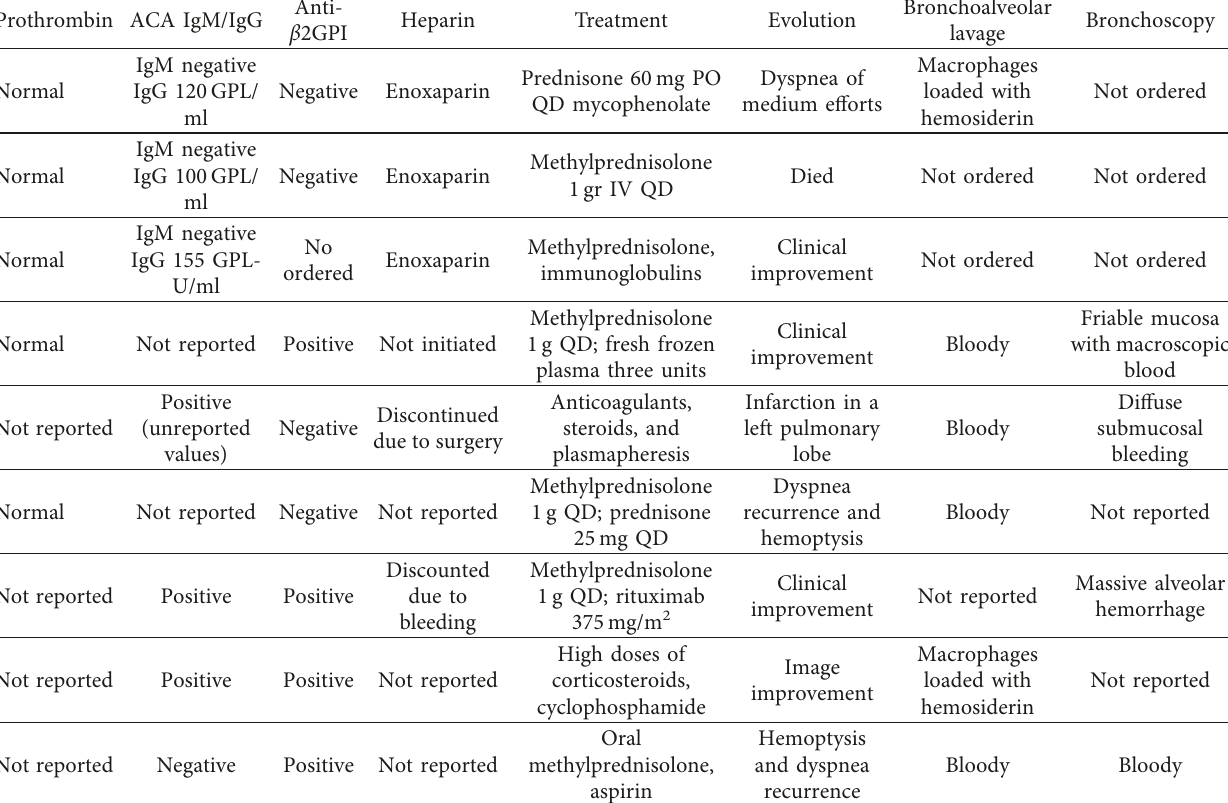
Table 4: Comparison of characteristics of patients with alveolar